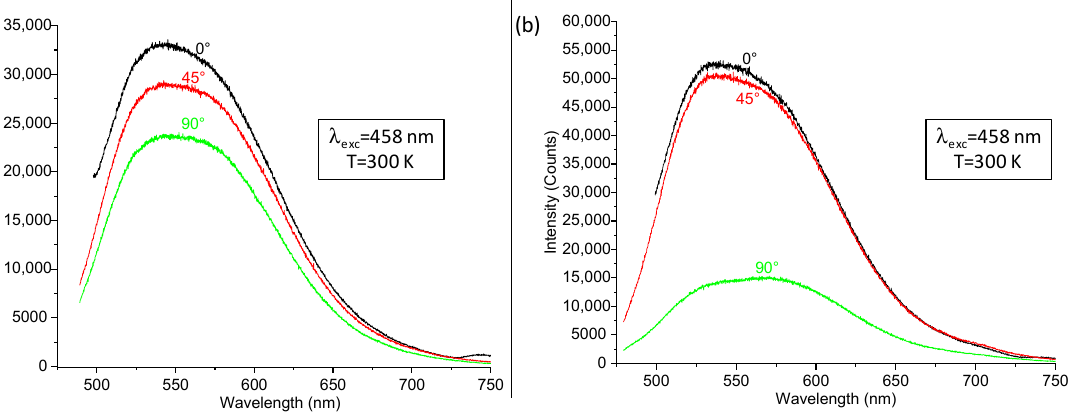
Figure 7. Room temperature angle-dependent emission spectra recorded for YAG:Ce ( a ) without and ( b ) with ZnO NWs under a 458 nm excitation. Excitation source strikes the sample perpendicularly in its back (corresponds to 0°).